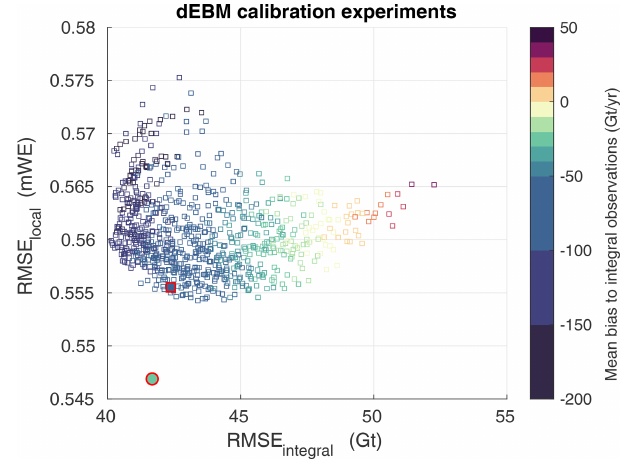
Figure 5. Root-mean-square error of the calibration experiments to temporal variations in the integral observation as a function of the root-mean-square error of calibration experiments to local ob- servations. The mean bias between observations and calibration ex- periments has been removed before root-mean-square errors were calculated. Colors represent the mean bias of the calibration exper- iments to integral observations. The experiment with the parameter combination which was selected for all following experiments is highlighted as a filled square with red borders. Also shown is ex- periment dEBM MAR , ERA as a solid circle, which uses the same selected parameter combination but different forcing (see Sect.